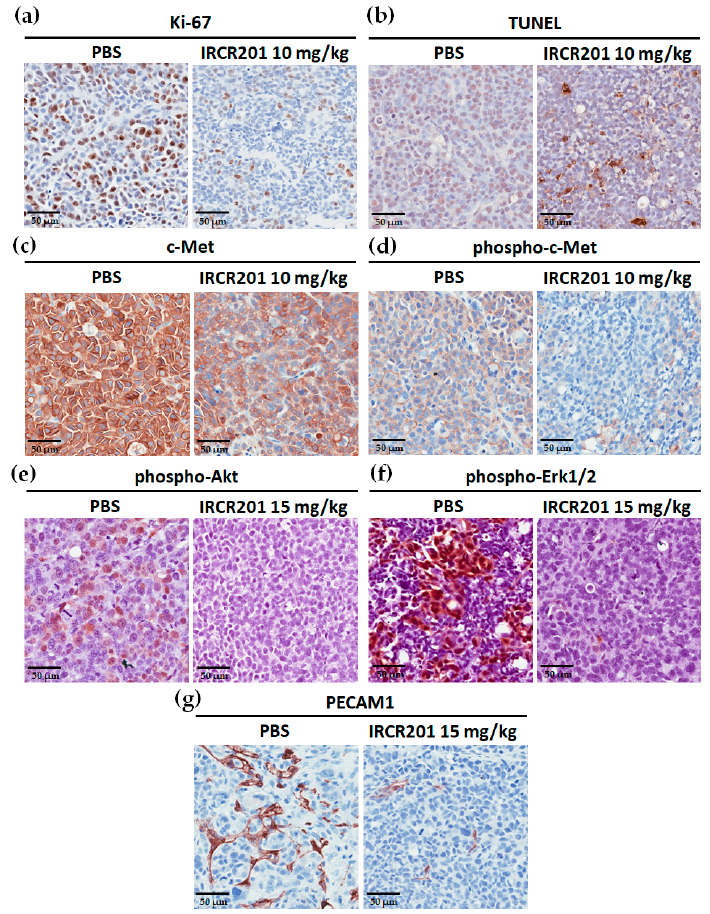
Figure 9. Immunohistological staining of Ki-67, apoptotic cells, c-Met, phospho-c-Met, phospho-Akt, phospho-Erk1/2, and platelet endothelial cell adhesion molecule 1 (PECAM1) in an MKN45 xenograft mouse tumor model. ( a – g ) All the immunohistochemistry (IHC) images were obtained at the same magnification. Sections were counterstained with hematoxylin (blue); ( a – d ) Immunohistochemistry analysis of MKN45 tumors in mice at 48 h post-treatment with 10 mg/kg IRCR201. The control group was intravenously injected with PBS (vehicle); ( a ) Immunohistological staining of MKN45 tumor section for Ki-67 (brown); ( b ) Immunohistochemistry analysis of apoptotic cells (brown) using the terminal deoxynucleotidyl transferase dUTP nick end labeling (TUNEL) assay; ( c , d ) IHC expression images of total c-Met (brown) and phospho-c-Met (brown) in the MKN45 tumor section at 48-h post-treatment at 10 mg/kg; ( e – g ) Immunohistochemistry analysis of phospho-Akt, phospho-Erk1/2, and PECAM1 on 15 mg/kg IRCR201-treated MKN45 tissue sections; ( e , f ) IHC expression images of phospho-Akt (brown) and phospho-Erk1/2 (brown) in the MKN45 tumor sections; ( g ) Immunohistological analysis of PECAM1-positive blood vessels (brown) in the 15 mg/kg IRCR201-treated MKN45 xenograft tumor section.